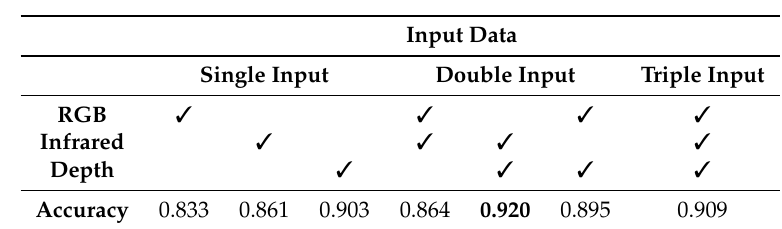
Table 3. Accuracy of the proposed multimodal system. Specifically, we report results individually exploiting one type of input (“single input”) and all the possible combinations of multiple modalities. As reported, the use of depth maps and infrared images represents the best choice in terms of gesture recognition